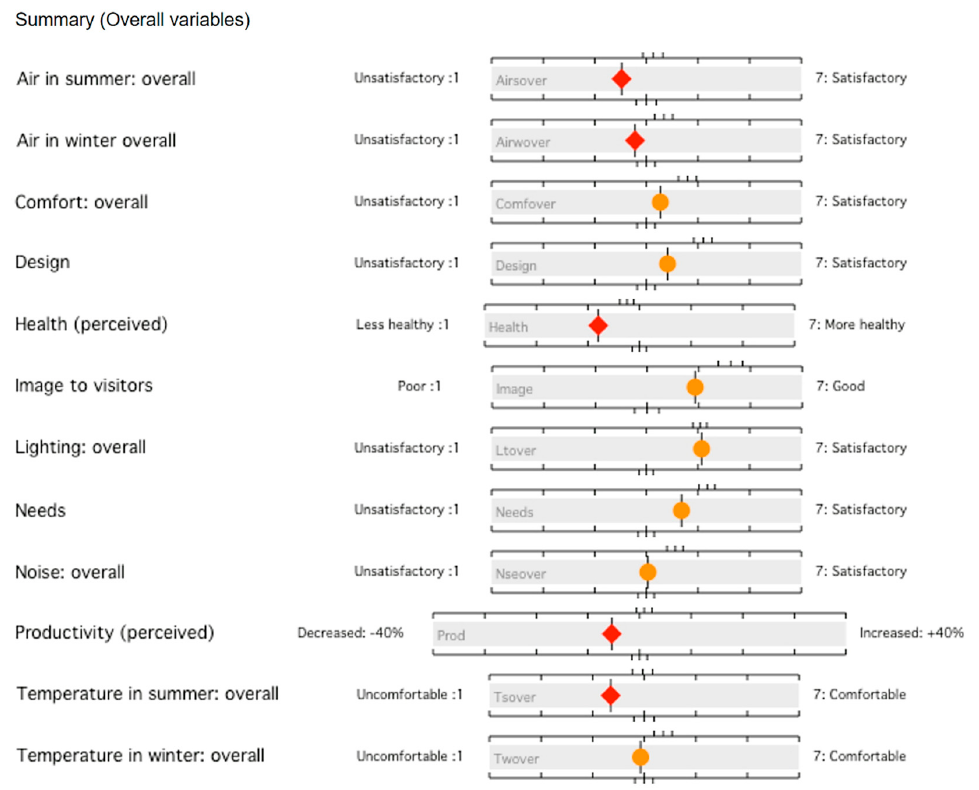
Figure 18. Post Occupancy Evaluation summary chart for staff (source: Building Use Studies).